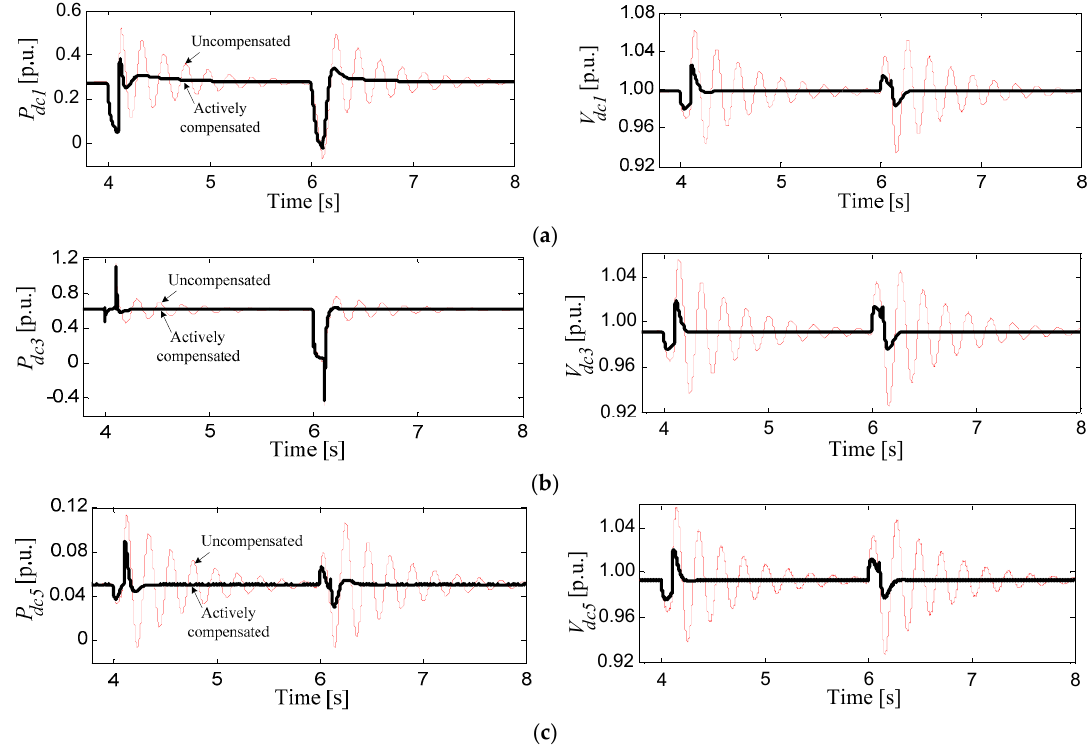
Figure 10. The compensated and uncompensated system response toward a five-cycle three-phase fault at ac-side of VSCs 1 and 3 at t = 4 and 6 s, respectively. ( a ) VSC 1; ( b ) VSC 3; ( c ) DC/DC converter 5.